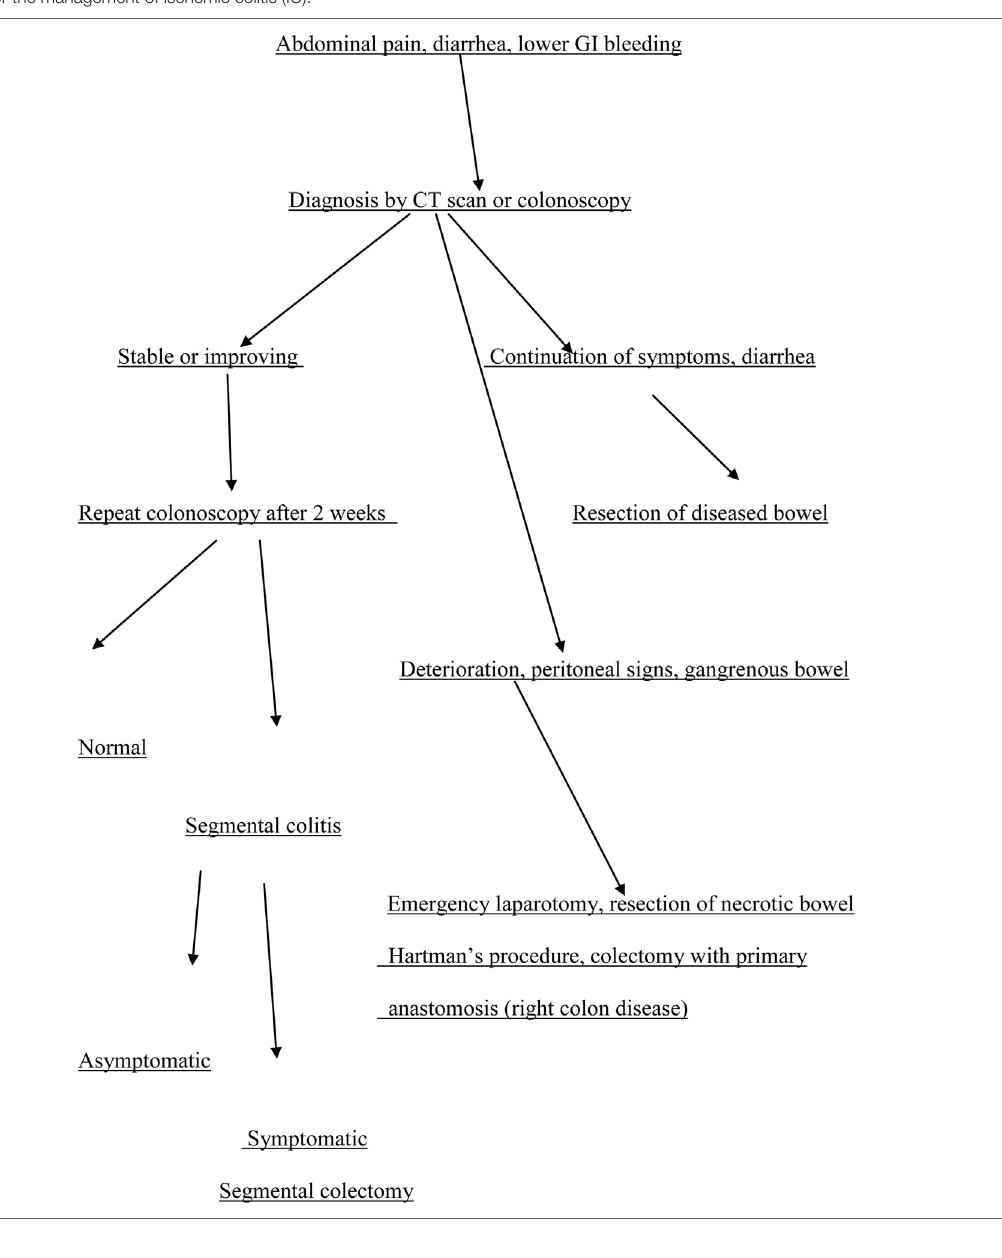
TABLe 2 | Algorithm for the management of ischemic colitis